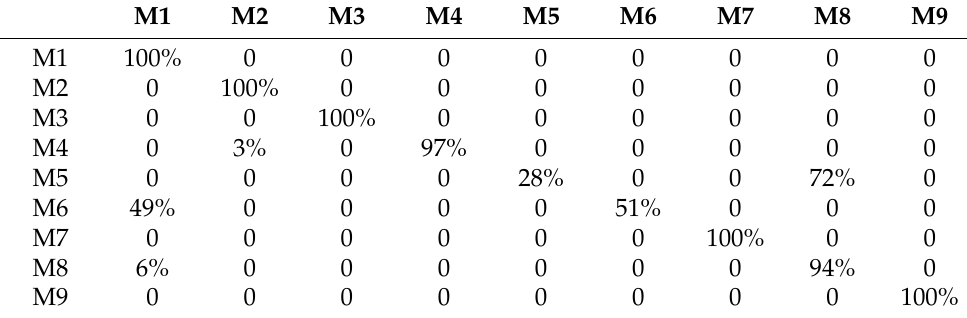
Table 5. Confusion matrix for the Orignal Cycle